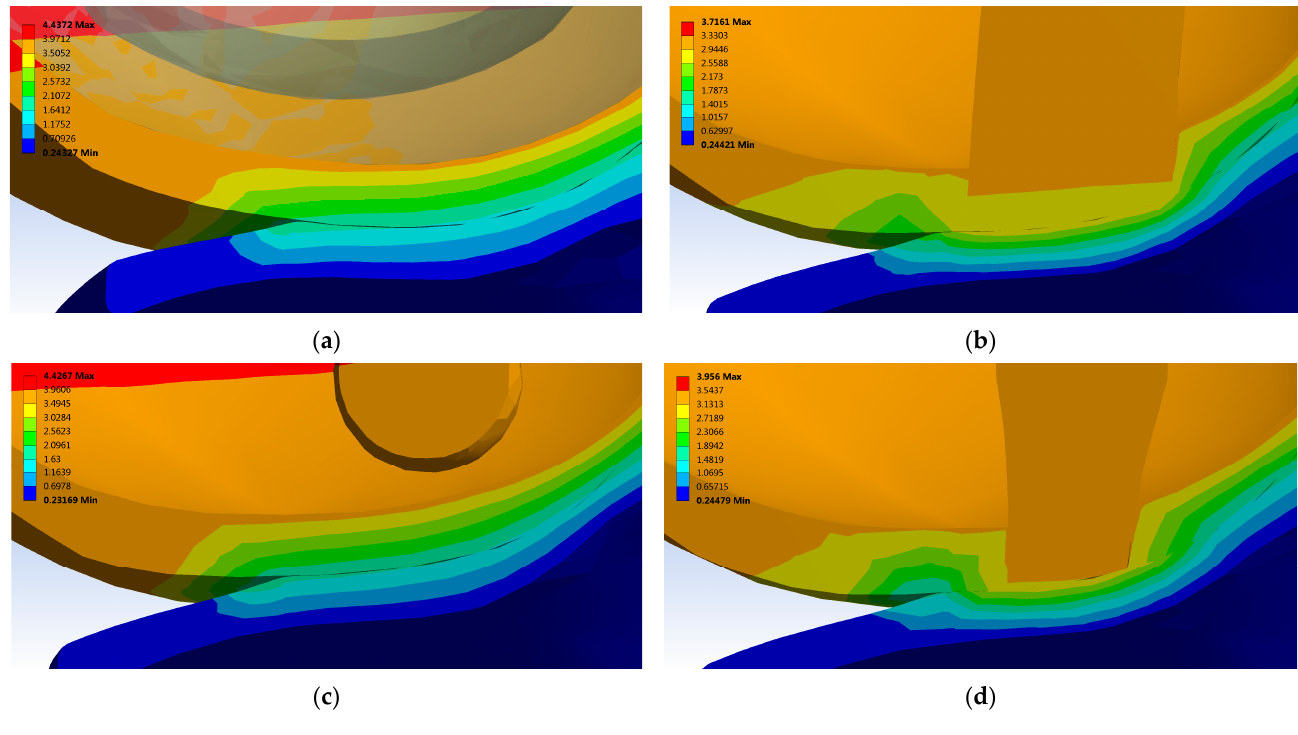
Figure 7. Total deformation in contact area of cartilage after applying a normal pressure of 0.38 MPa: ( a ) Case 0 (healthy knee); ( b ) Case 1 (just porous Collagen); ( c ) Case 2 (Collagen + BMC); ( d ) Case 3 (Collagen + ASC).